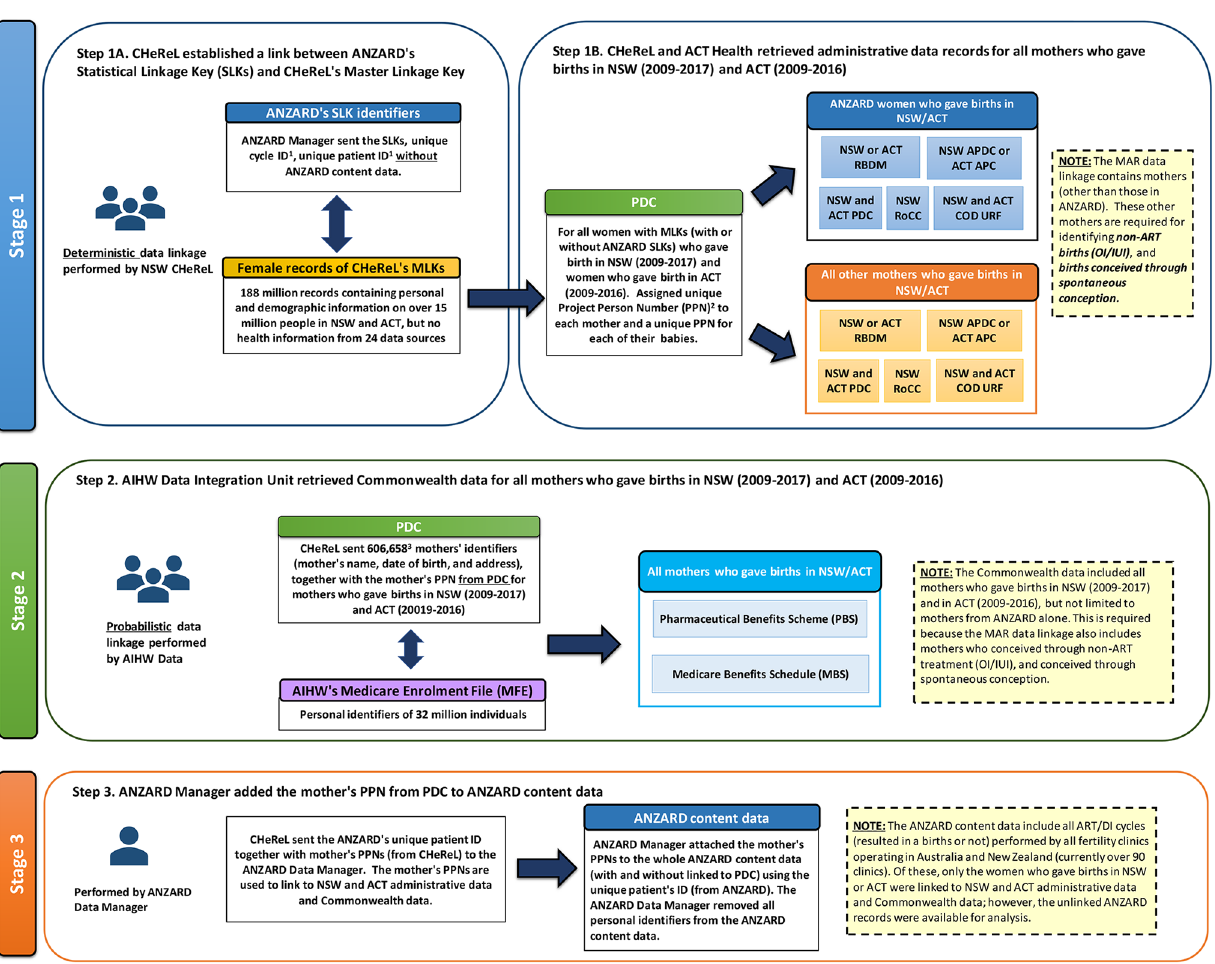
Figure 1: An overview of the data linkage process for the medically assisted reproduction (MAR) data